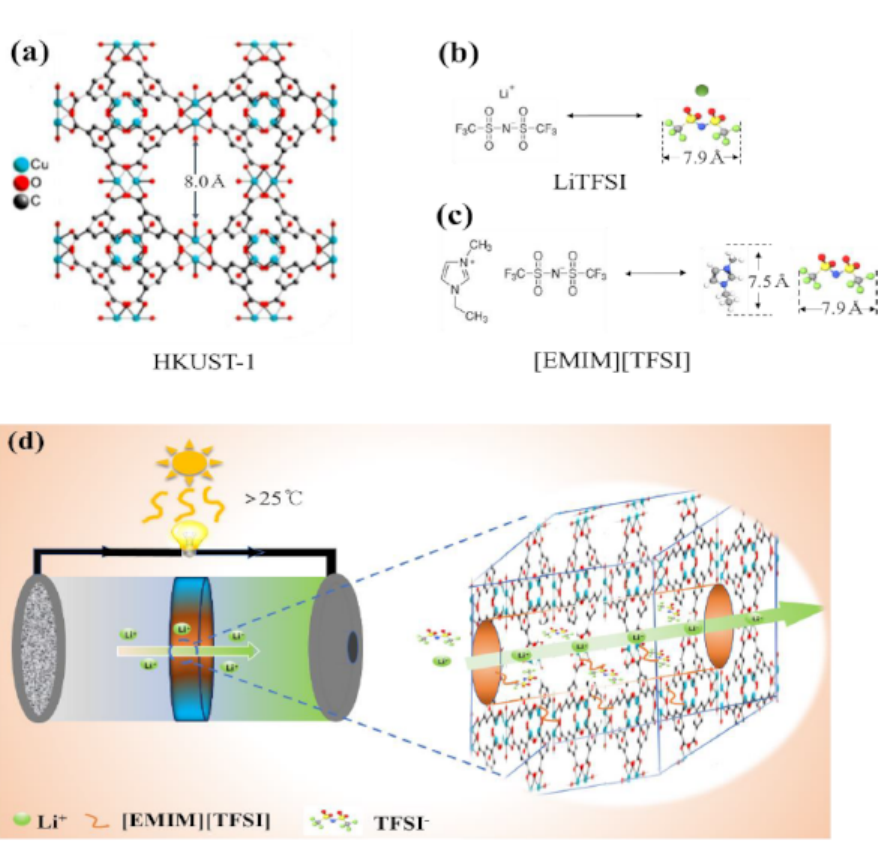
Figure 1. Molecular structures of ( a ) HKUST-1 metal–organic framework (MOF), ( b ) LiTFSI salt, and ( c ) [EMIM][TFSI] ionic liquid, and ( d ) schematic illustration of Li + transport in 3D ionic nanochannels of solid